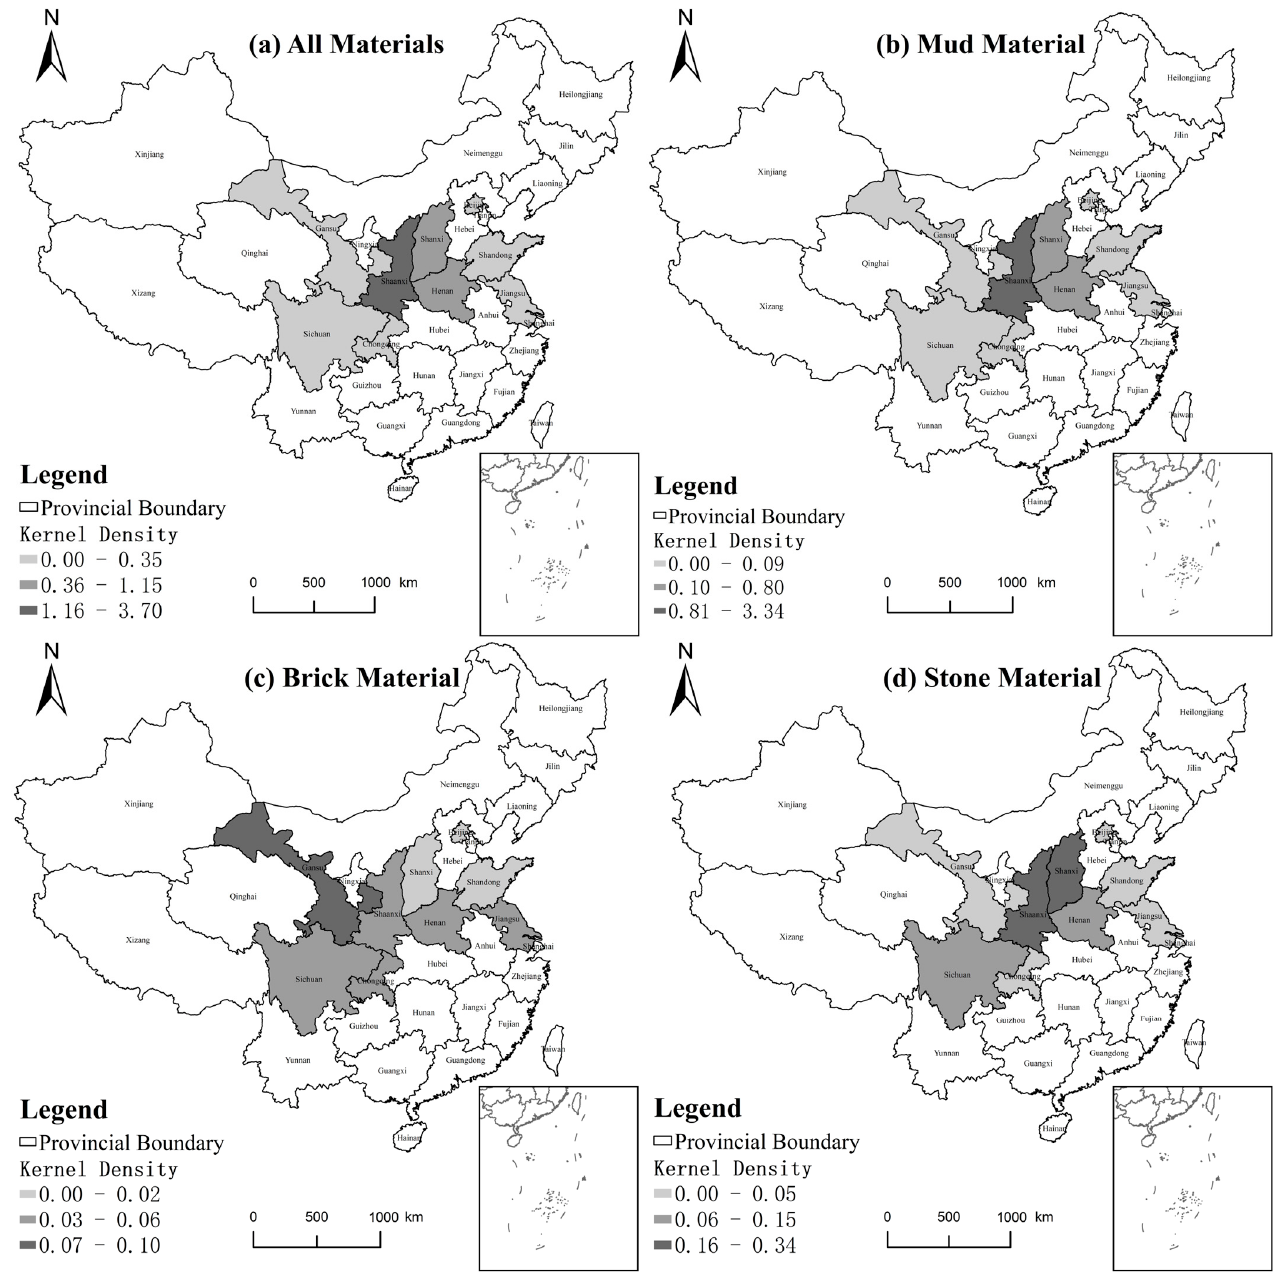
Figure 7. Distribution map of the kernel density of the types of relic sites in the Sui, Tang, and Five Dynasties.